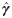
Scenario I. Coefficient of determination (R2) and root mean square error (RMSE) resulting from the solution of the linear regression problem with least-squares for the case fatality ratio (γ^).